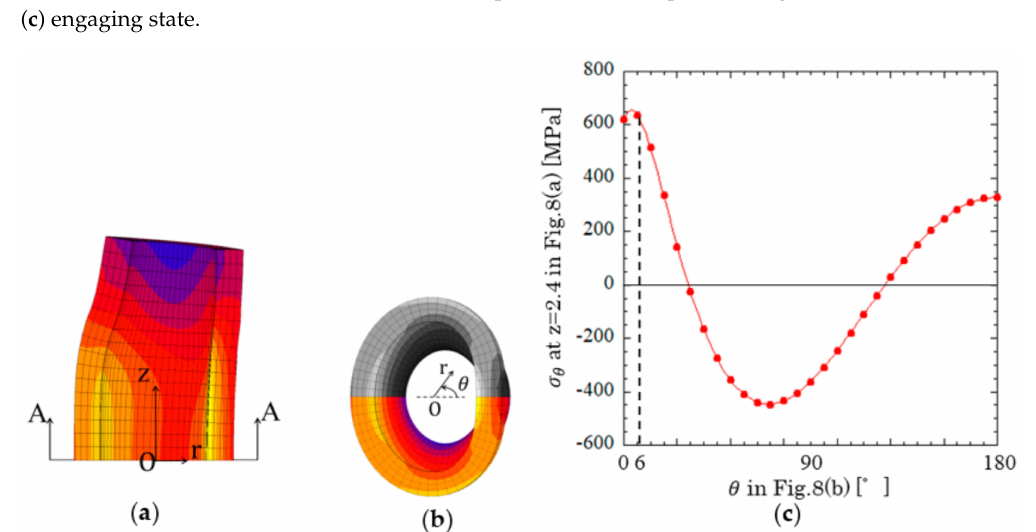
Table 5. Maximum stress Figure 8. Bush deformation and σ θ at inner surface: ( a ) bush deformation [50 times enlarged in the r-direction]; ( b ) A–A cross section deformation [50 times enlarged in the r-direction]; ( c ) σ θ at inner surface in Figure